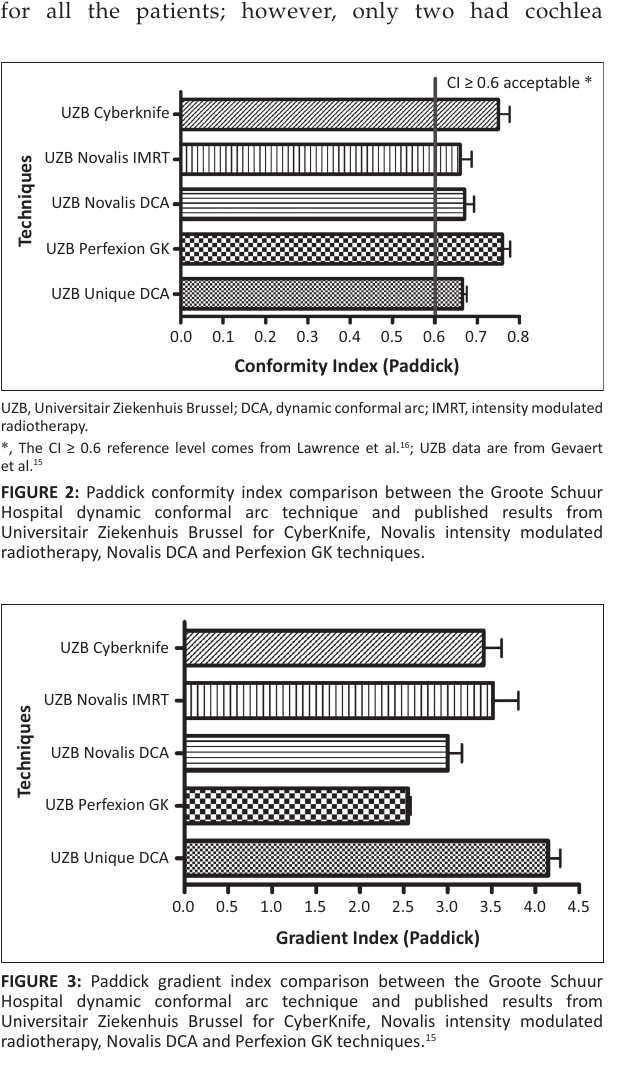
FIGURE 1: Radiation Therapy Oncology Group radiosurgery criteria results for the Groote Schuur Hospital dynamic conformal arc technique.